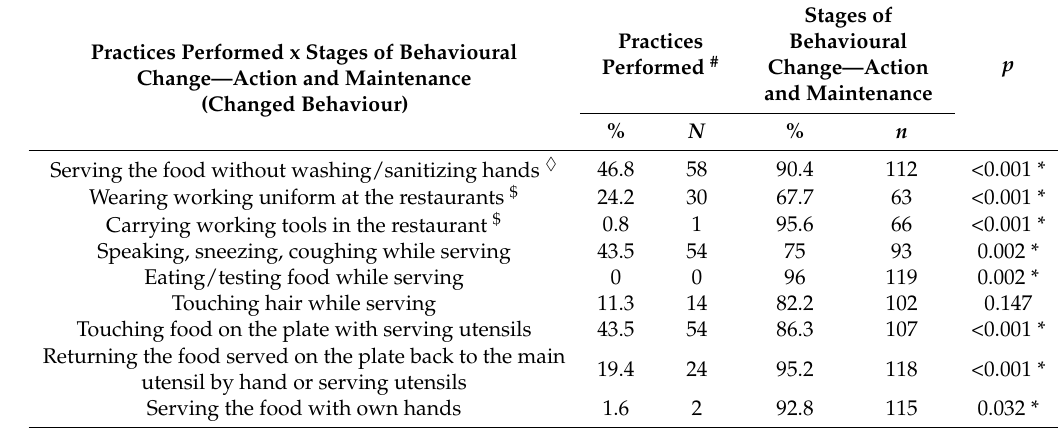
Table 2. Correlation between the proportion of unhygienic practices and the stages of behaviour change (Changed Behaviour: represented by the Action and the Maintenance